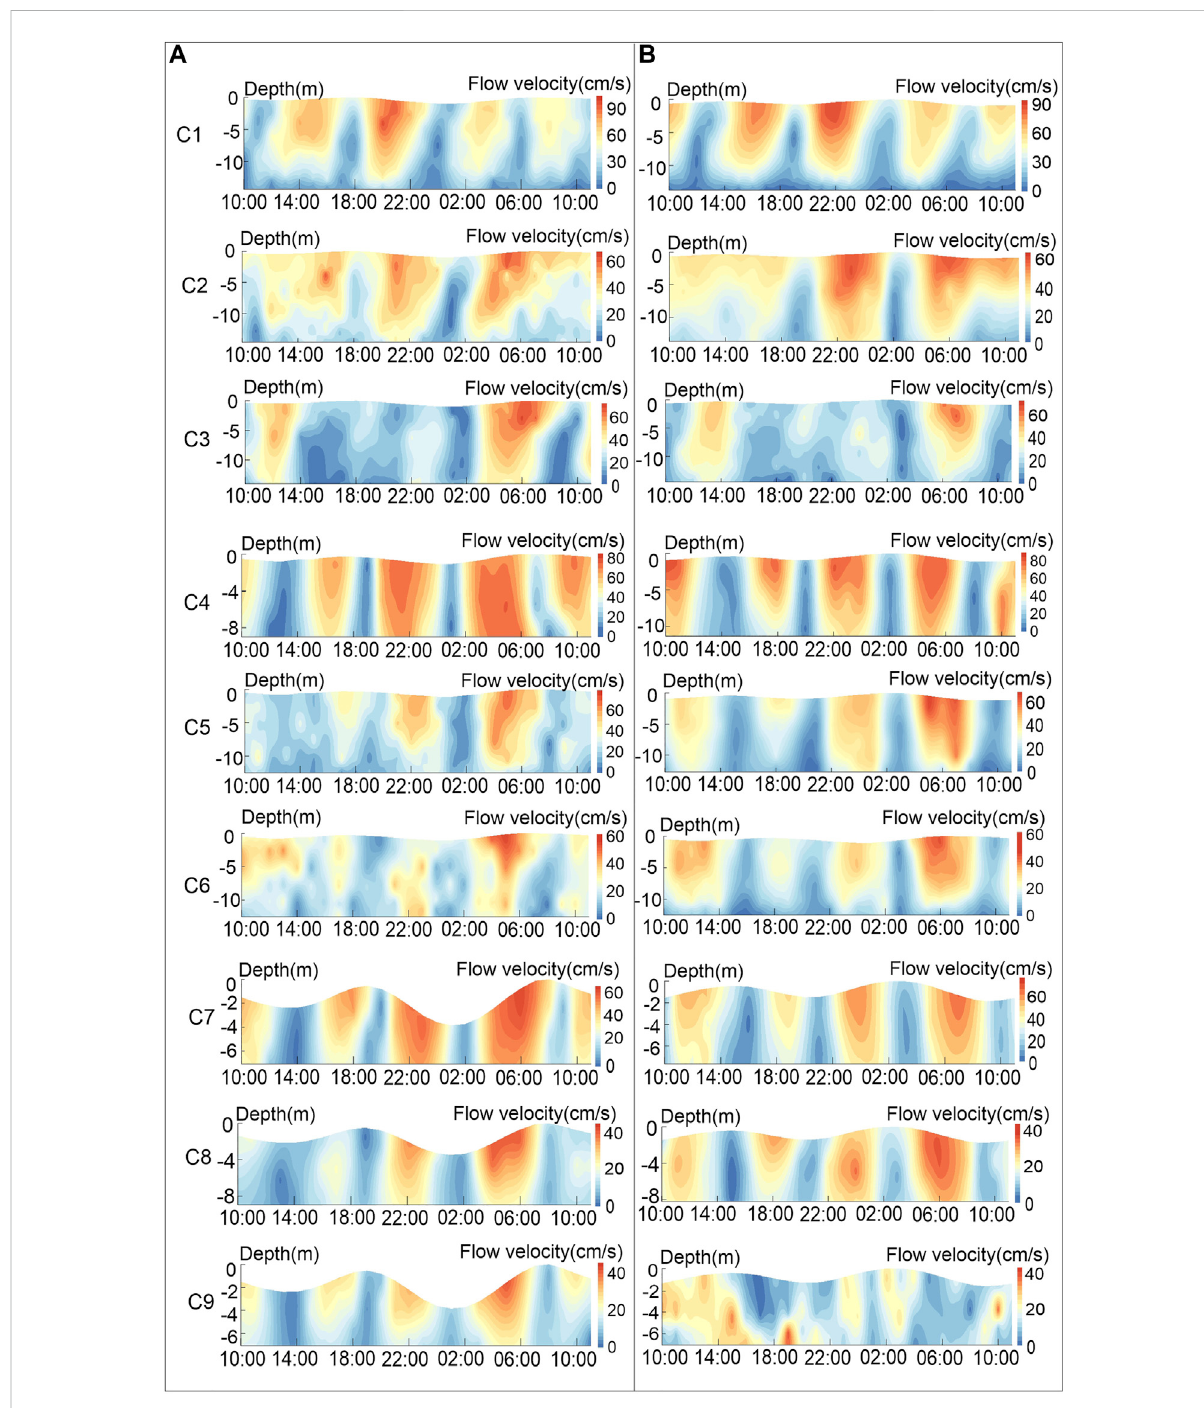
FIGURE 6 Flow velocity pro fi les at various stations for the spring (A) and moderate (B)